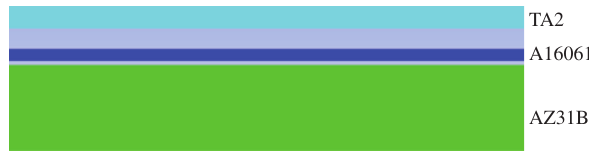
Figure 3: The model drawing of Ti/Al/Mg in the